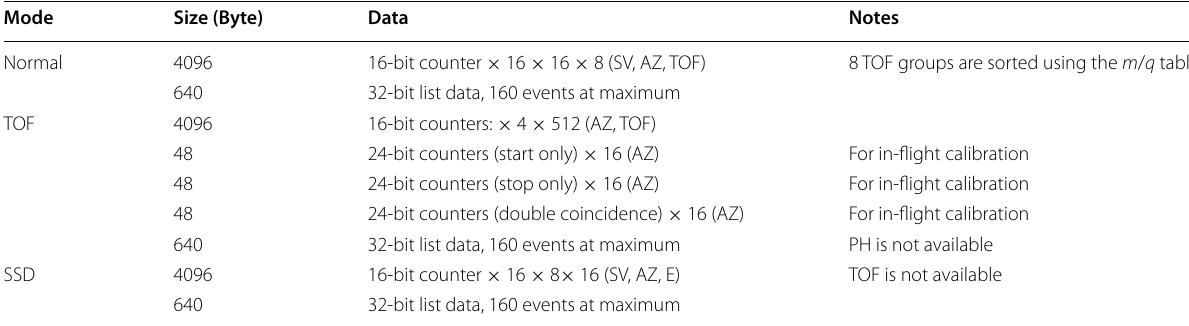
Table 2 Observation modes of the MEP-i